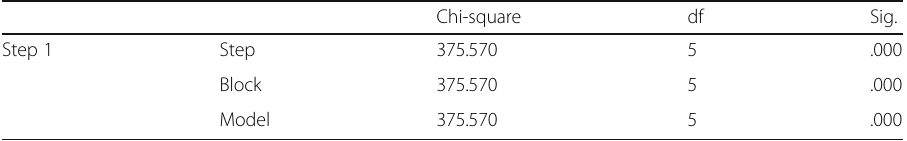
Table 4 Omnibus Tests of Model